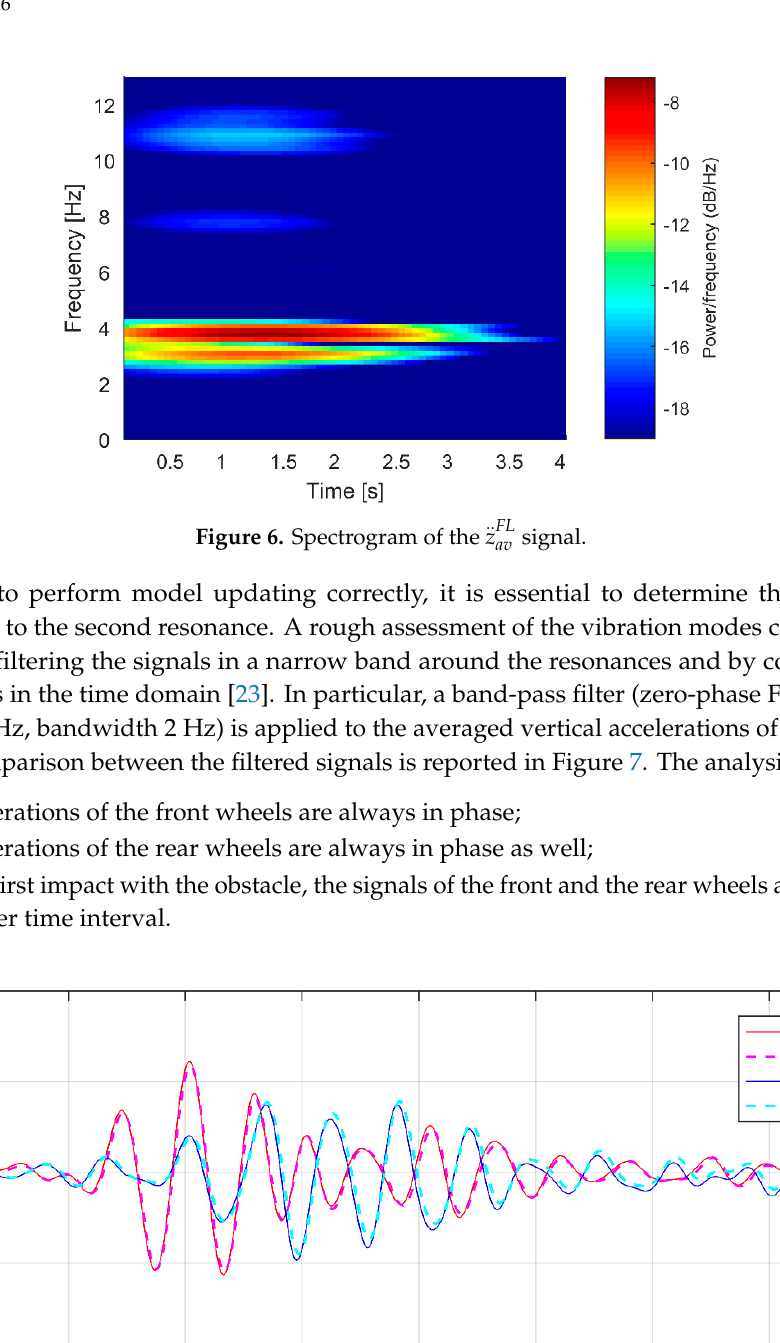
Figure 7. Comparison between the filtered signals of the front left (FL), front right (FR), rear left (RL), and rear right (RR) wheel hubs.